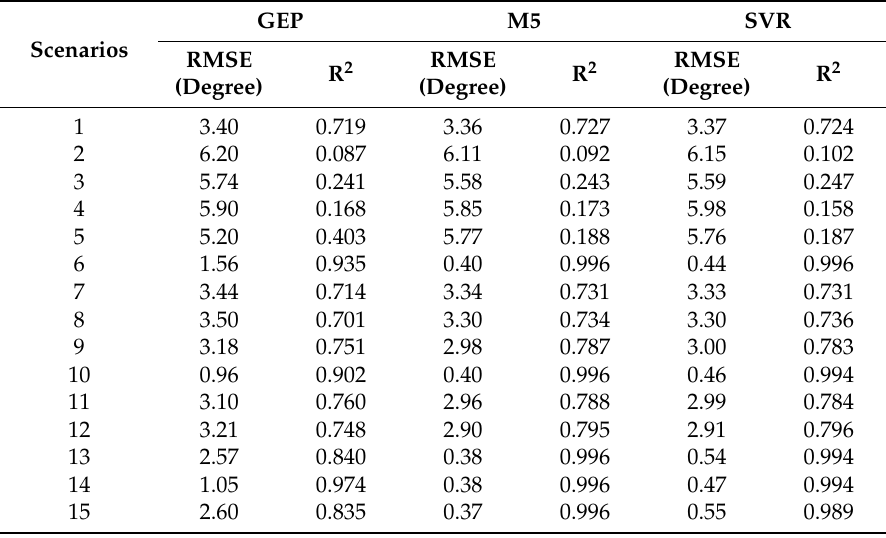
Table 4. Evaluation of the performance of GEP, M5 model tree (M5), and support vector regression (SVR) models in the testing